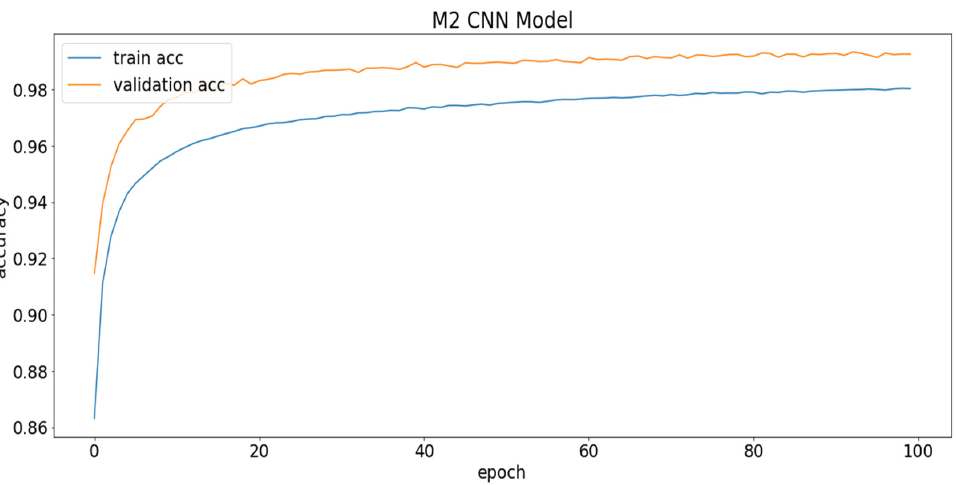
Figure 9. M2 model train vs. validation accuracy graph on valence class.